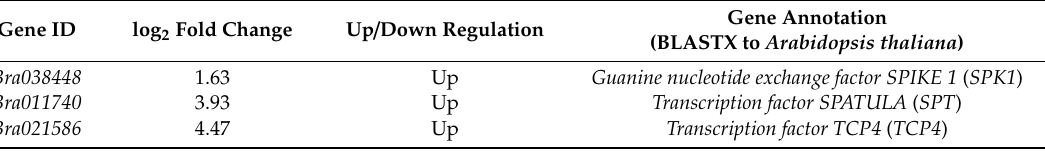
Table 2. The di ff erentially expressed genes associated with petal development (pdm vs. ‘FT’). Gene ID log 2 Fold Change Up / Down Regulation